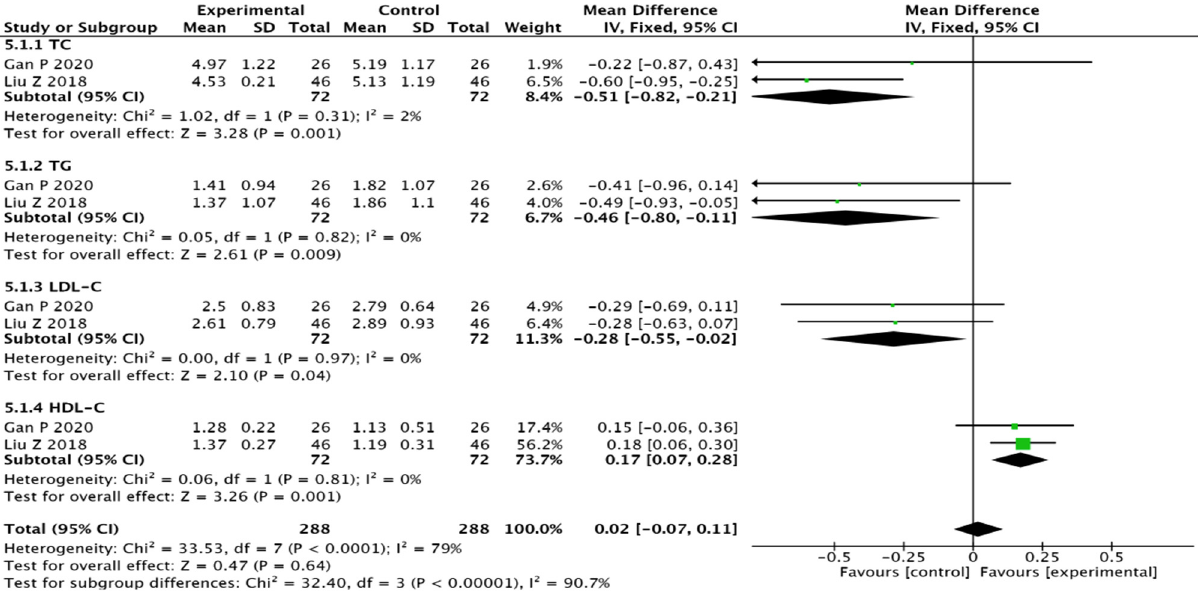
Figure 9. Meta-analysis forest plot of blood lipids.